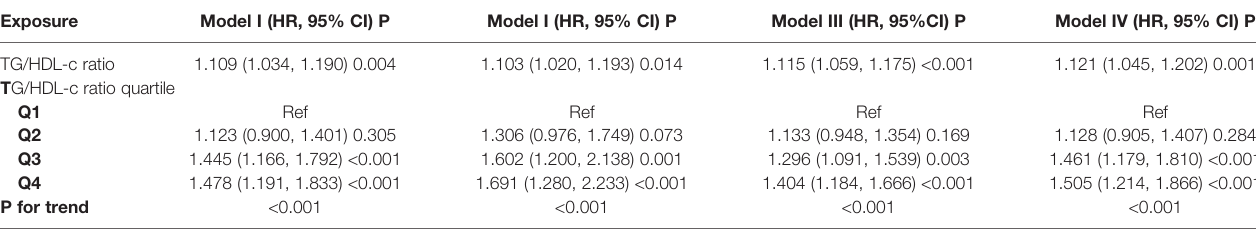
TABLE 5 | Relationship between TG/HDL-c ratio and the risk of diabetes in participants with prediabetes in different sensitivity analyses.